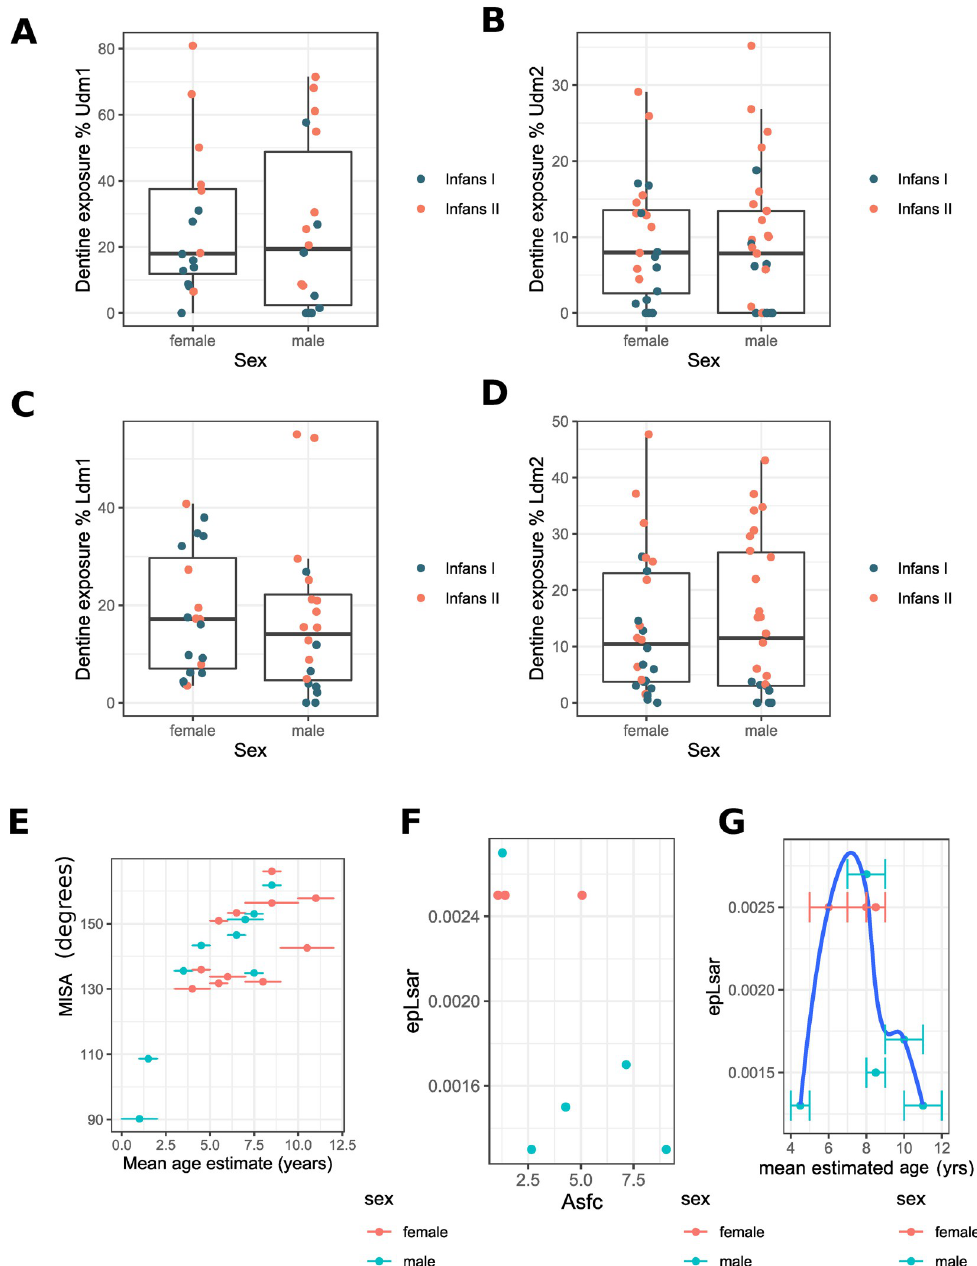
Fig 6. Sex-based differences in dental wear. ( A) Boxplot with jitter of the area of dentine exposure as a % of the occlusal surface of Udm1 divided by sex and coloured by age group. (B) Boxplot of the area of dentine exposure as a % of the occlusal surface of Udm1 divided by sex and coloured by age group. (C) Boxplot with jitter of the area of dentine exposure as a % of the occlusal surface of Udm1 divided by sex and coloured by age group. (D) Boxplot of the area of dentine exposure as a % of the occlusal surface of Udm1 divided by sex and coloured by age group. (E) Scatterplot of MISA by mean estimated age with age estimation uncertainty error bars coloured by sex. (F) Scatterplot of surface anisotropy (epLsar) by surface complexity (Asfc) coloured by sex. (G) Scatterplot of surface anisotropy (epLsar) by mean estimated age with age estimation uncertainty error bars, a loess curve is used to better represent the non-linear relationship between the variables, coloured by